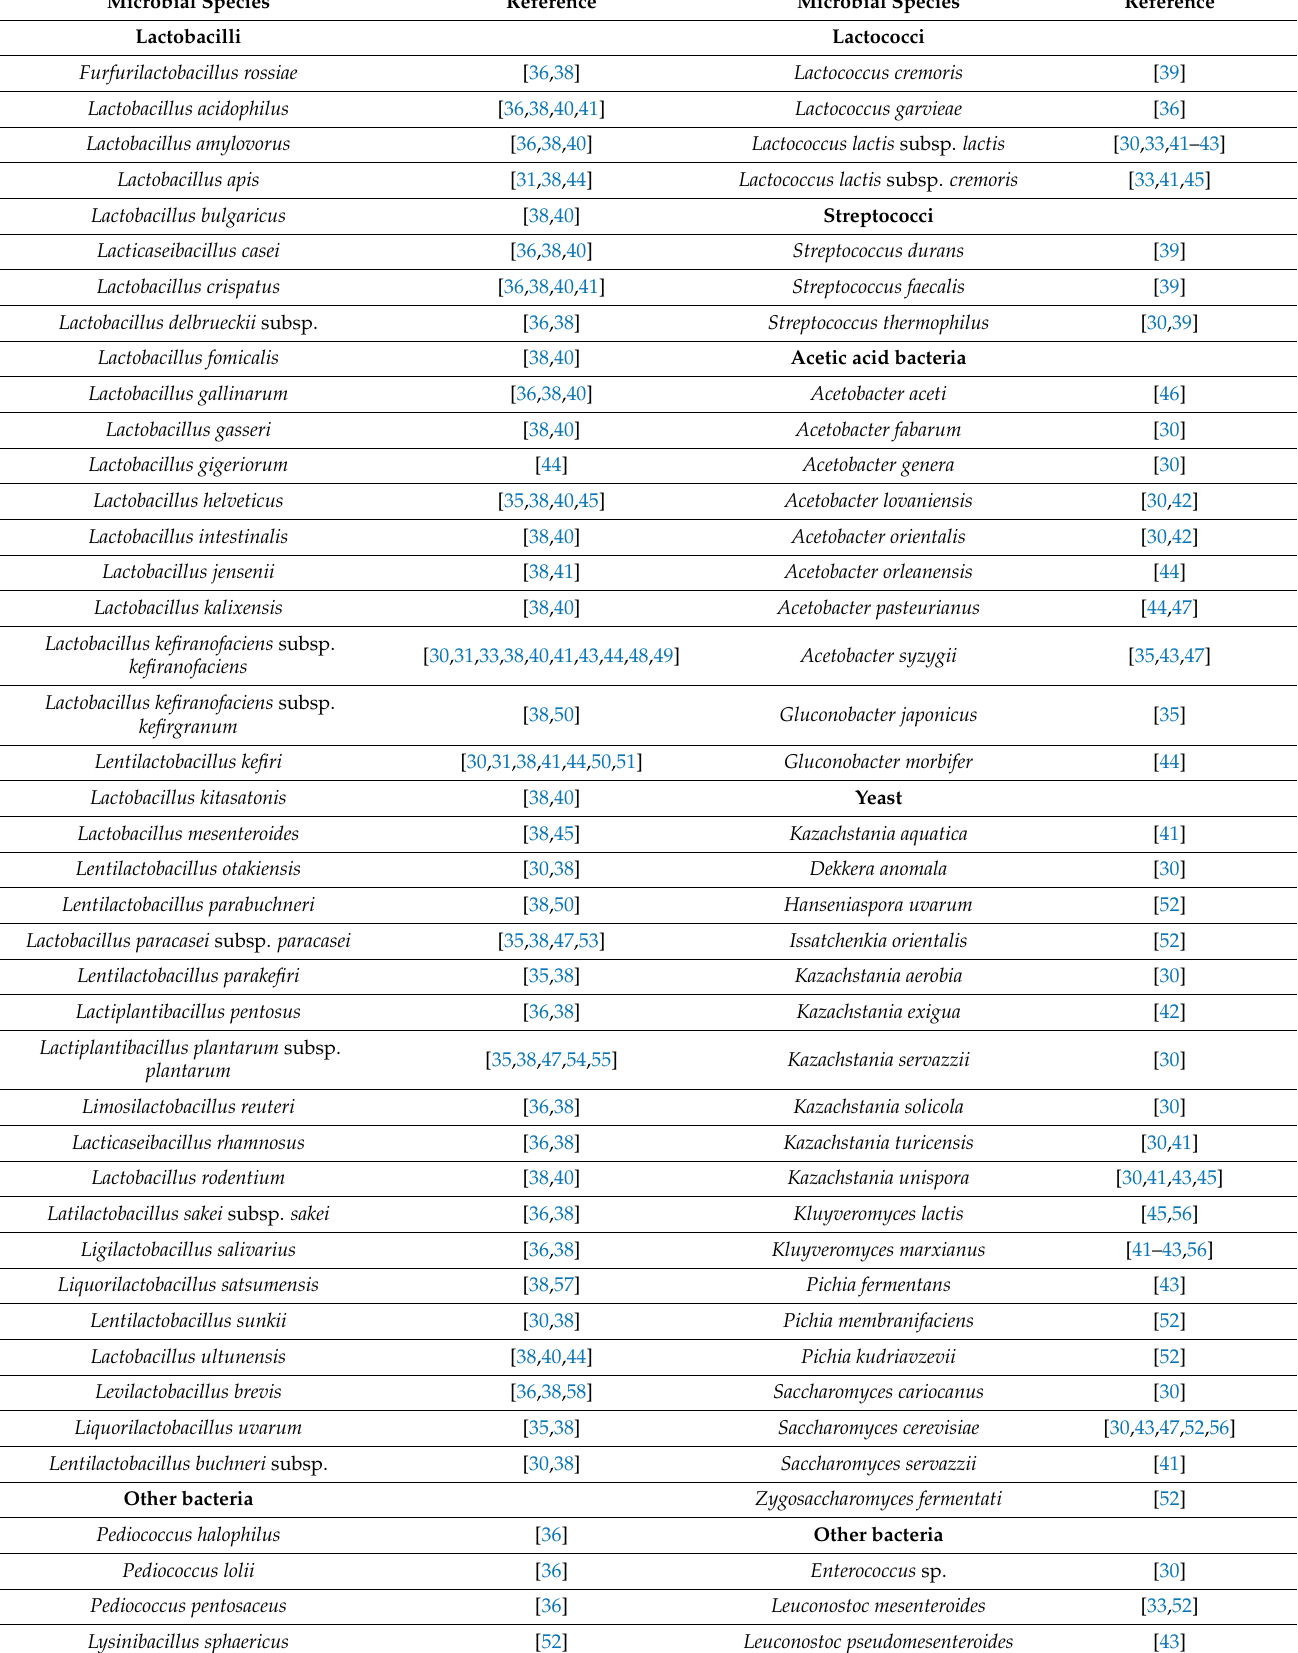
Table 1. Variety of microbial species isolated from